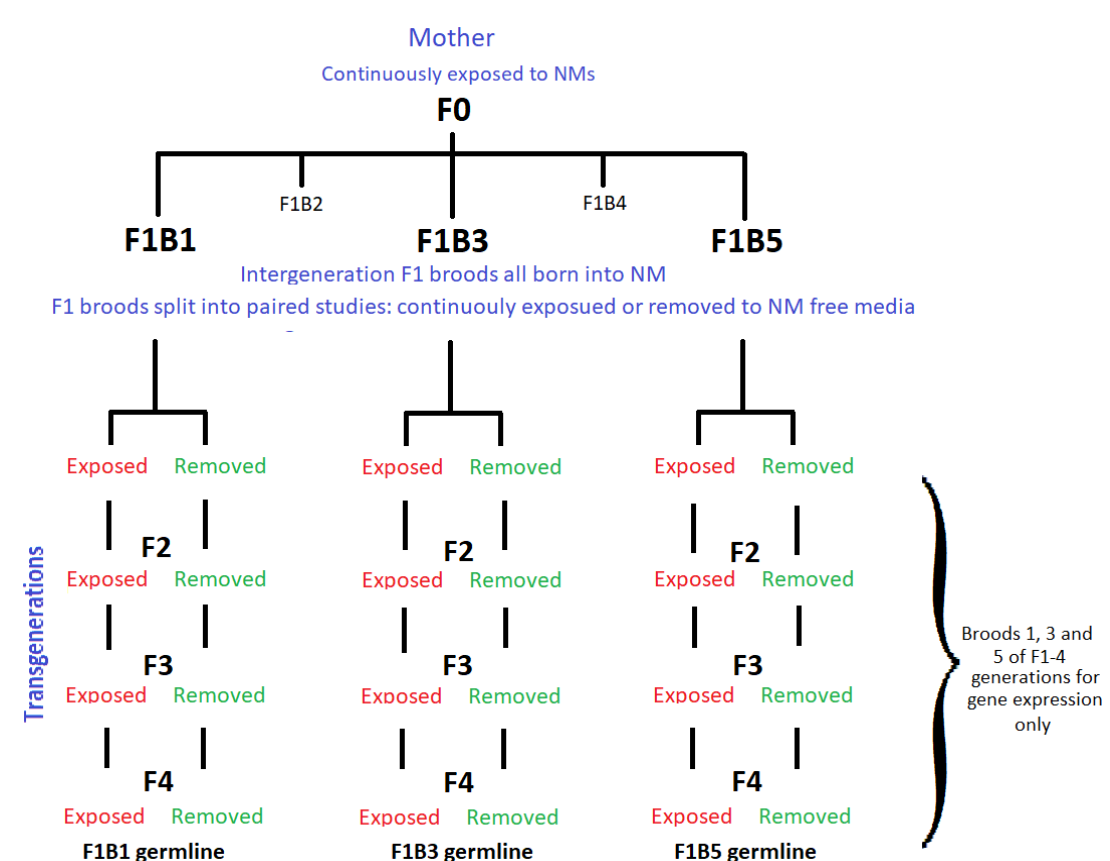
Figure 7. Multigenerational design showing the exposed and recovery generations after the F0 parental exposure. The intergeneration’s of the F1 broods born of F0 (F1B1, F1B3 and F1B5) are then monitored over the transgenerations, following each of the germlines from F2-F4 thereafter for each brood. Note, the F1 recovery generations are born into NM-exposure but removed within 24 h of birth, to assess the recovery potential and whether there are epigenetic effects from the maternal exposure. The red text shows the exposed transgenerations within each germline during continuous exposure. The green text shows the exposed transgenerations within each germline in the recovery generations.